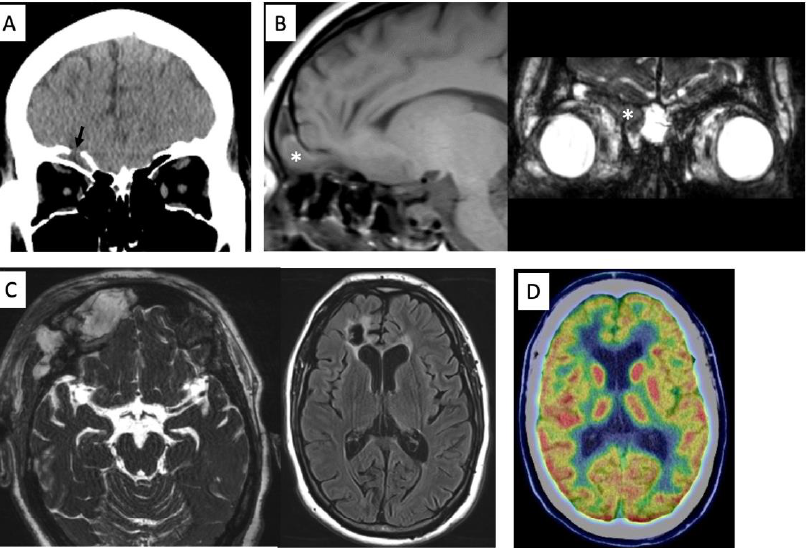
Figure 1. Preoperative computed tomography showing the anterior skull base defect (arrow) ( A ). MR images showing a prolapsed right rectal gyrus into the frontal sinus on T1-weighted image and constructive interference in steady state (CISS) (*) ( B ). Postoperative MRI showing adequate removal of the encephalocele and scar in the right frontal lobe on CISS and FLAIR images ( C ). 18F-fluorodeoxyglucoce PET showing hypometabolism in right lateral frontal cortex ( D ).